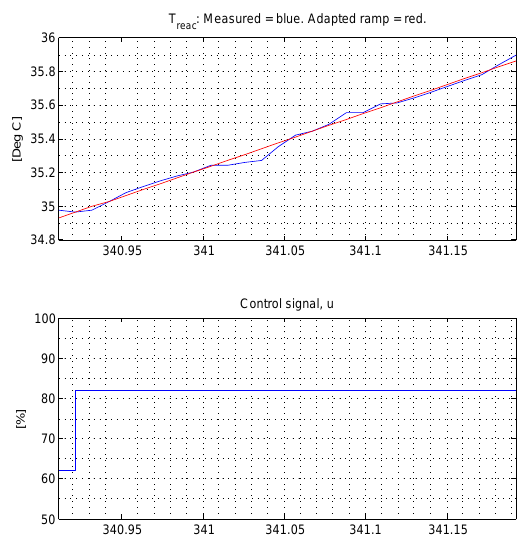
Figure 6: The response in T reac (upper plot, blue) due to a step change in the control signal, u , (lower diagram) from 62% to 82% ( ∆ u = 20% ), and the ramp-wise response (upper plot, red) adapted to T reac . (The sampling time of the data is 15 min = 0.0104